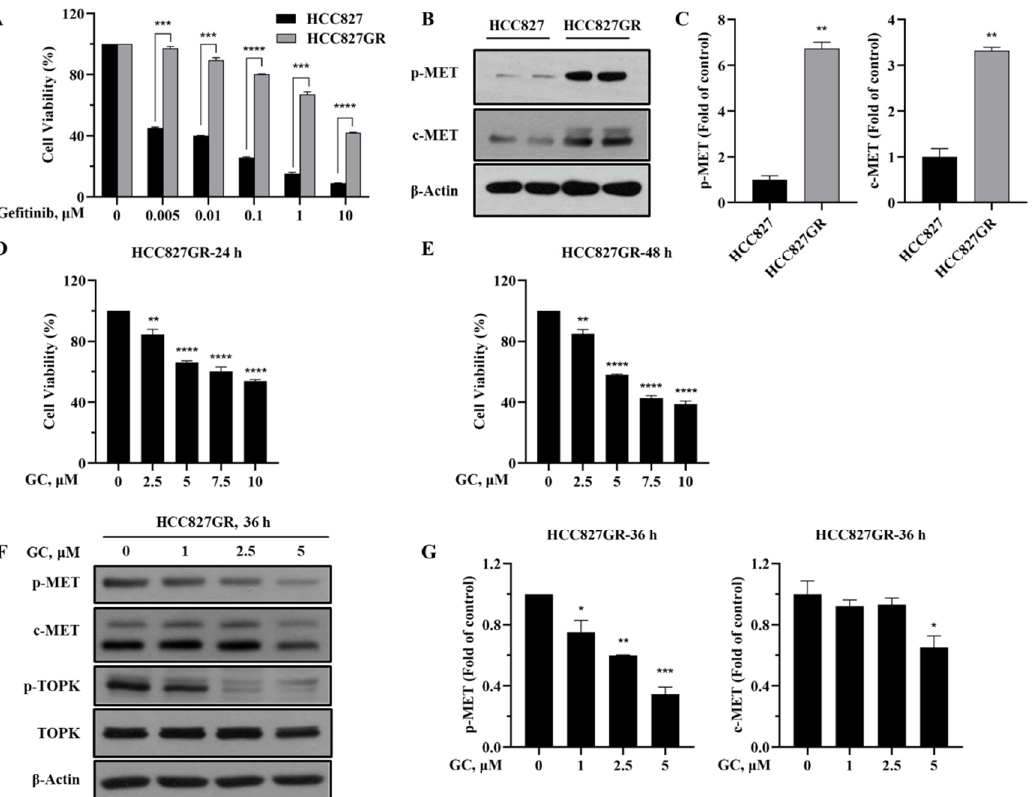
Figure 1. Exposure to glycyrol (GC) leads to reduced viability of HCC827 GR cells in vitro. ( A ) Comparison of the sensitivity of HCC827 and HCC827GR cells to gefitinib. ( B , C ) Comparison of MET activation between HCC827 and HCC827GR cells (two replicates). ( D , E ) Effect of GC on cell viability of HCC827GR cells. ( F , G ) Influence of GC on MET activation in HCC827GR cells. * p < 0.05, ** p < 0.01, *** p < 0.001, **** p < 0.0001.